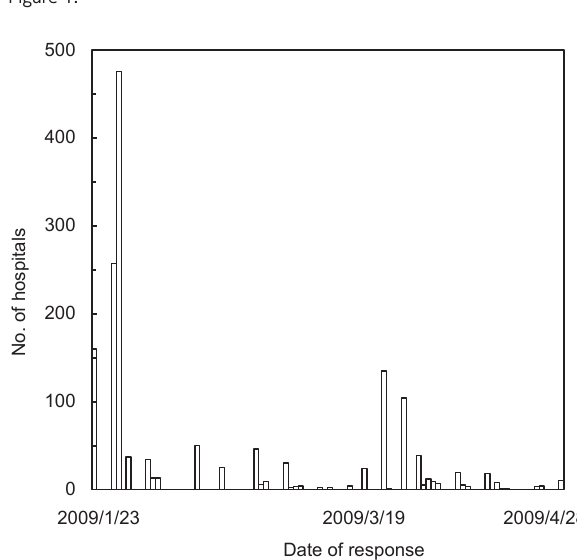
Distribution of the dates on which hospitals responded to the nationwide epidemiological survey of eosinophilic granulomatosis with polyangiitis.